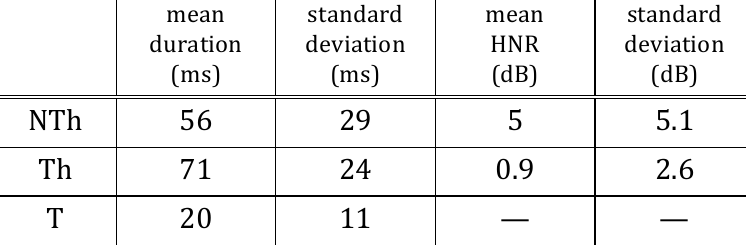
Table 6: Comparison of burst plus aspiration across voiceless